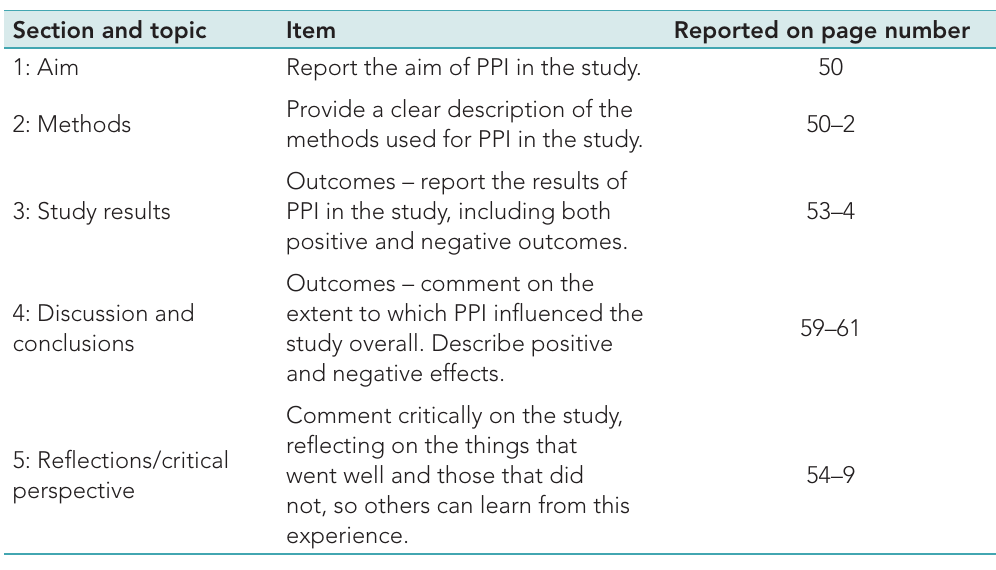
Table 1: Completed GRIPP2 checklist (short